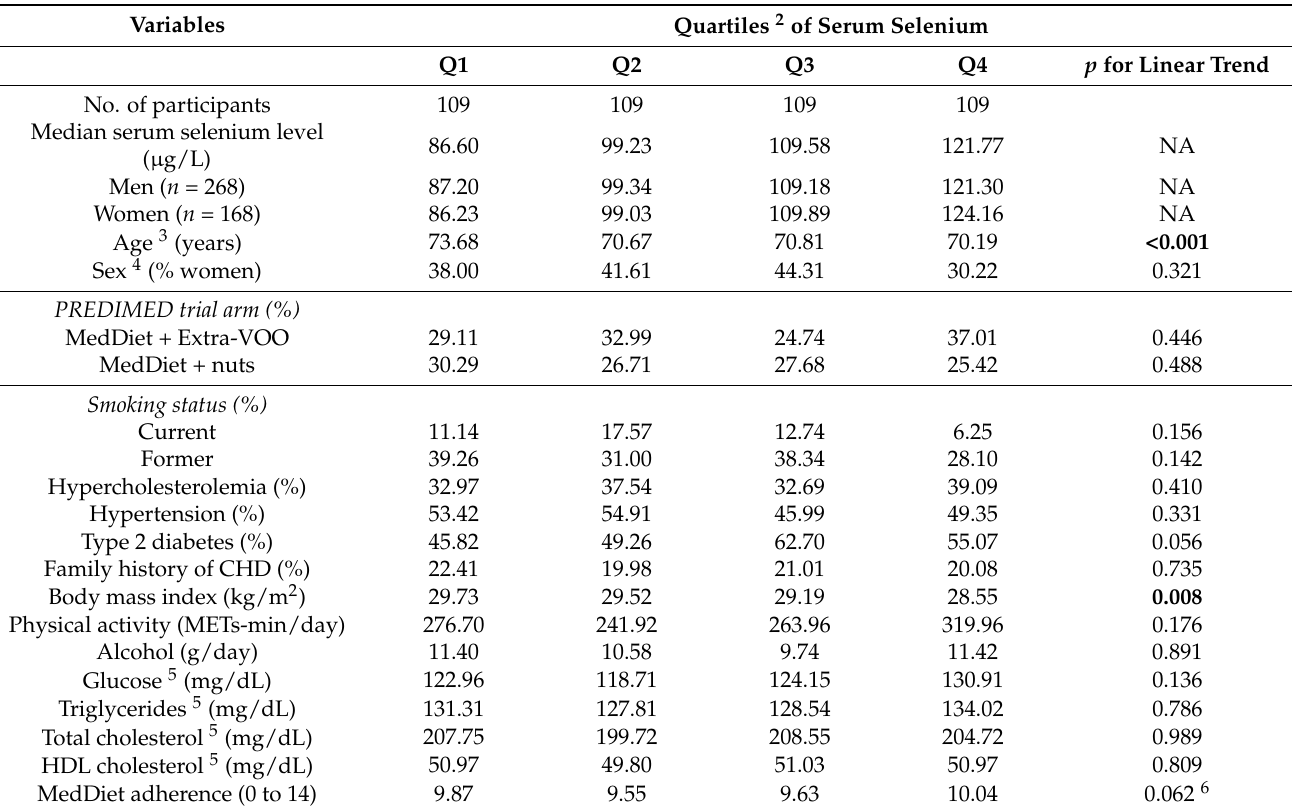
Table 2. Adjusted 1 characteristics of 436 controls by quartiles of serum selenium at sample collection